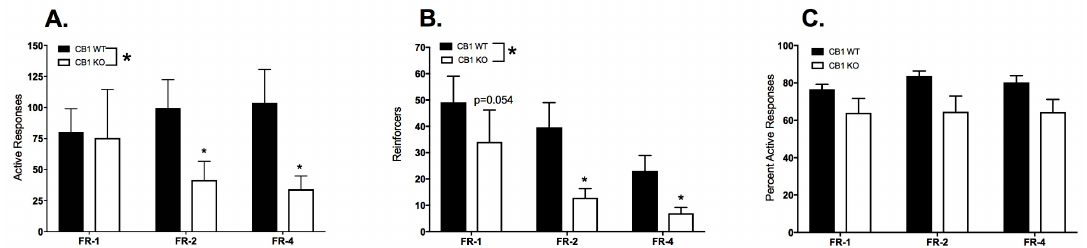
Figure 2. Comparison of FR-1, 2 and 4 responses and reinforcers earned in WT ( n = 9; filled bars) and CB1KO ( n = 12; open bars) mice. Bars represent mean ± SEM. ( A ) Mean responses in the active port; ( B ) Mean reinforcers earned; ( C ) Mean percent of total responses made in the active port. * p < 0.05.